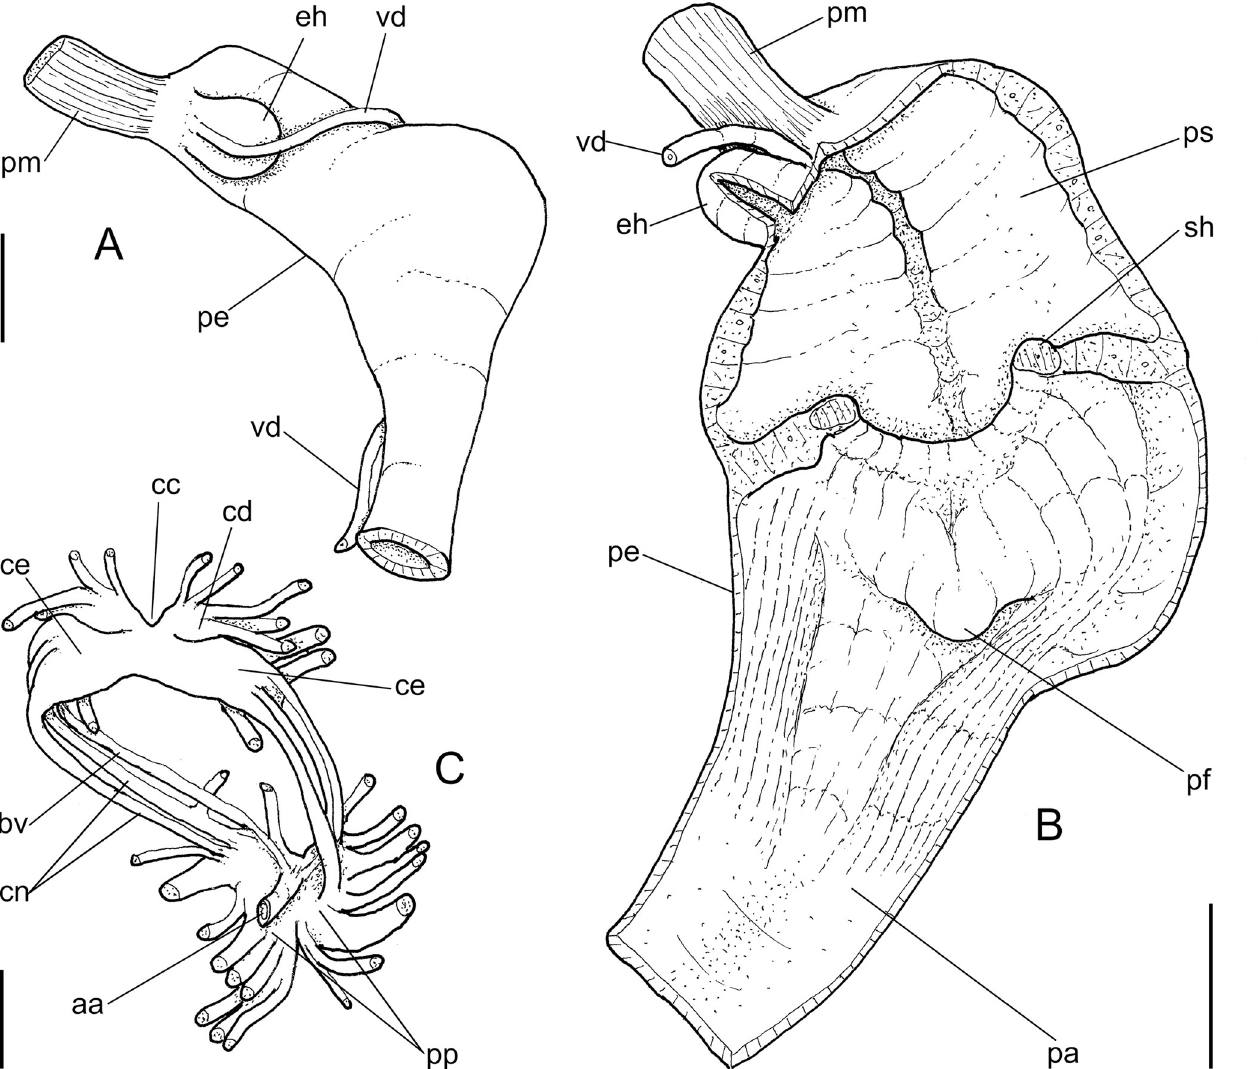
Fig 24. Catracca uhlei , anatomy. (A) Penis, dorsal view. (B) Same, sectioned longitudinally to show inner surface. (C) Nerve ring, dorsal view. Scales = 2 mm.